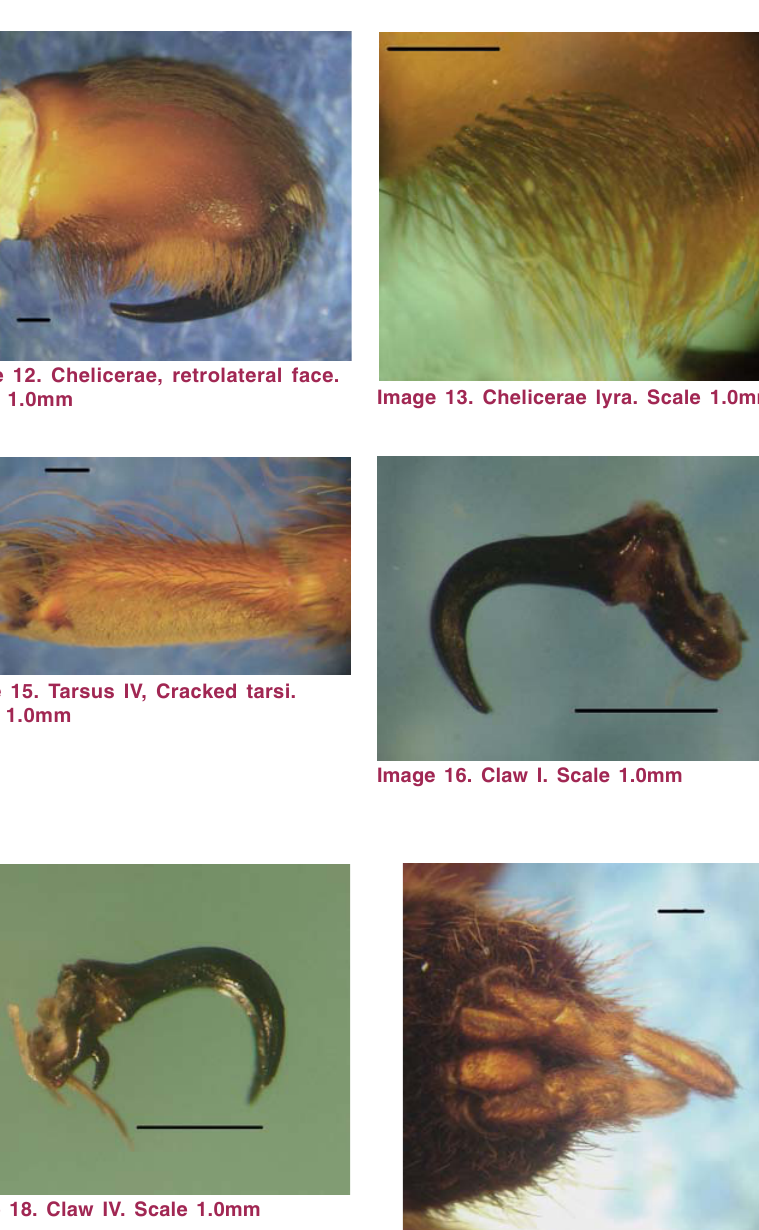
Image 19. Spinnerets. Scale 1.0mm